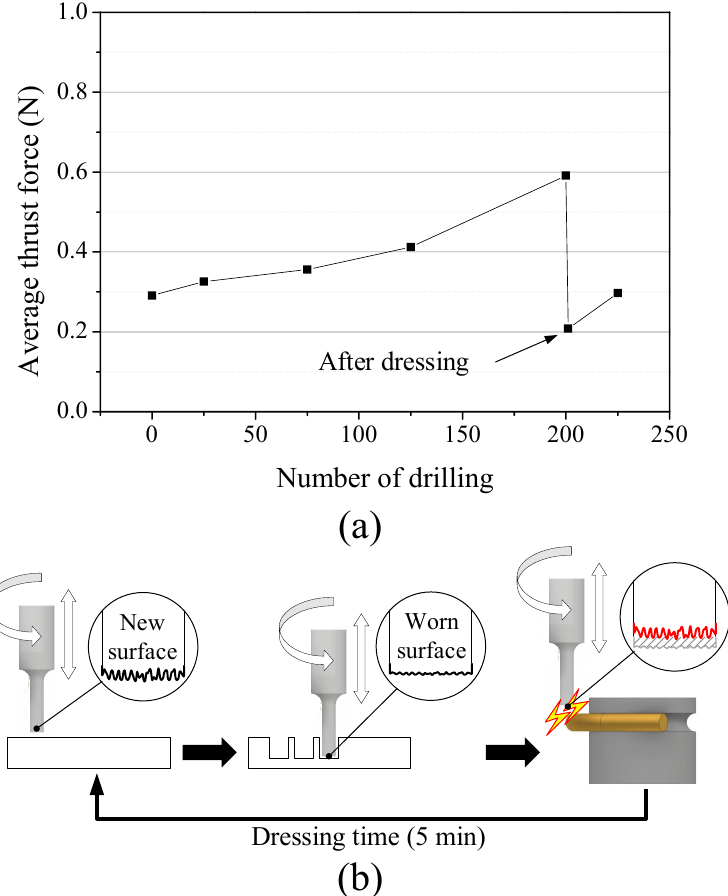
Figure 13. ( a ) Thrust force according to the number of drillings and ( b ) dressing process using WEDG (drilling conditions: axial feedrate 10 µ m/s; rotational speed of 50,000 rpm; dressing conditions: 100 V, 470,000